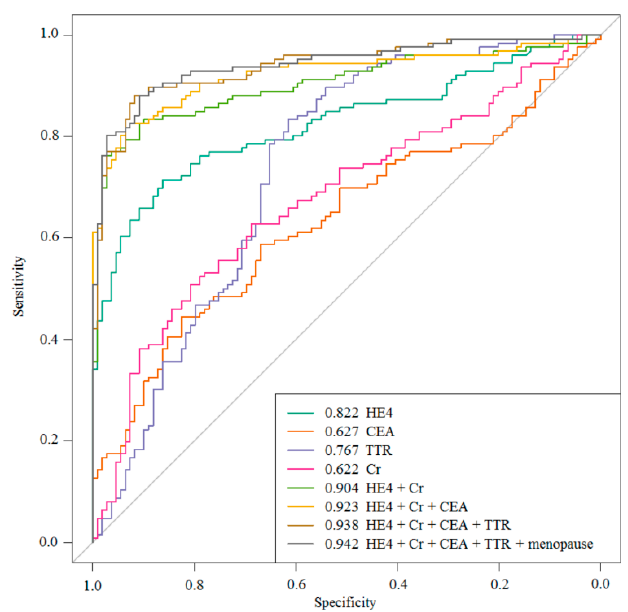
Figure 3. The ROC curve of the multimarker panels (i.e., HE4, creatinine, CEA, and TTR), and the results with the addition of menopausal status. Table 3. The performance of multimarker models to predict cancer over benign tissues between early- and advanced-stage cancer (this analysis was performed using 109 benign and 131 cancer samples).